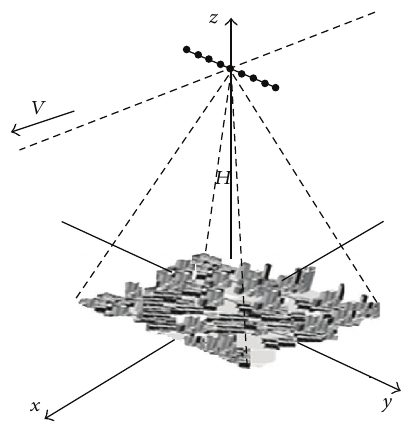
Figure 1: Geometry of down-looking MIMO array SAR. with the total space cells, representing strong spatial sparsity in high frequency radar application, we propose a new 3D imaging algorithm for down-looking MIMO array SAR based on BCS.